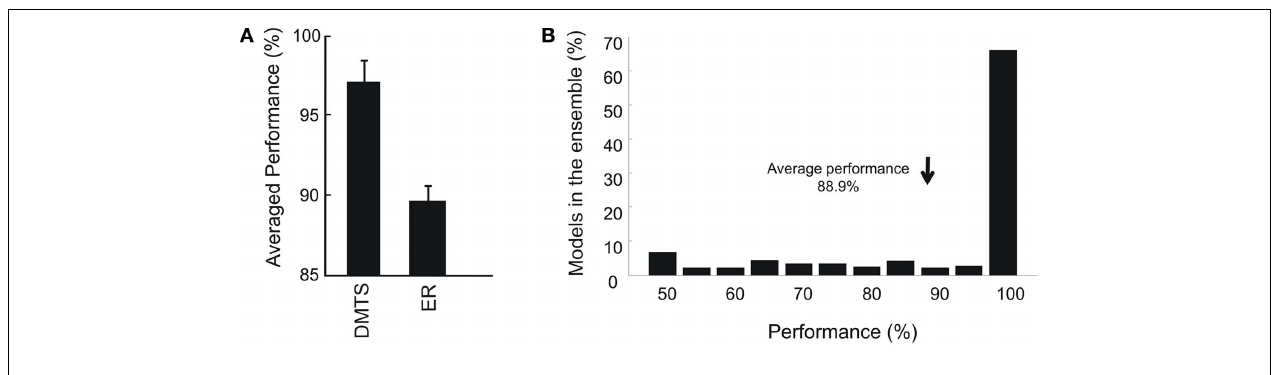
lines in Figure 2 ). (B) Normalized distribution of performances in the ensemble. It can be noted that while less than 70% of the models performs better than 90% in ER, the average performance of the ensemble is